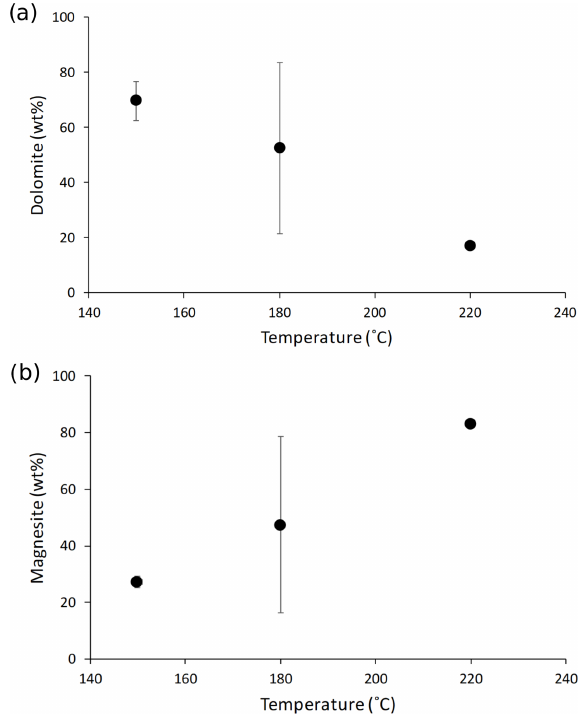
Figure 1. (a) Dolomite and (b) magnesite concentrations in the precipitated solid (in wt%) as a function of reaction temperature (in ◦ C). The data displayed are average values for each reaction temperature. The error is not shown for mineral concentrations at 220 ◦ C because no repeat analysis was performed. The error on the magnesite content at 150 ◦ C is within the symbol